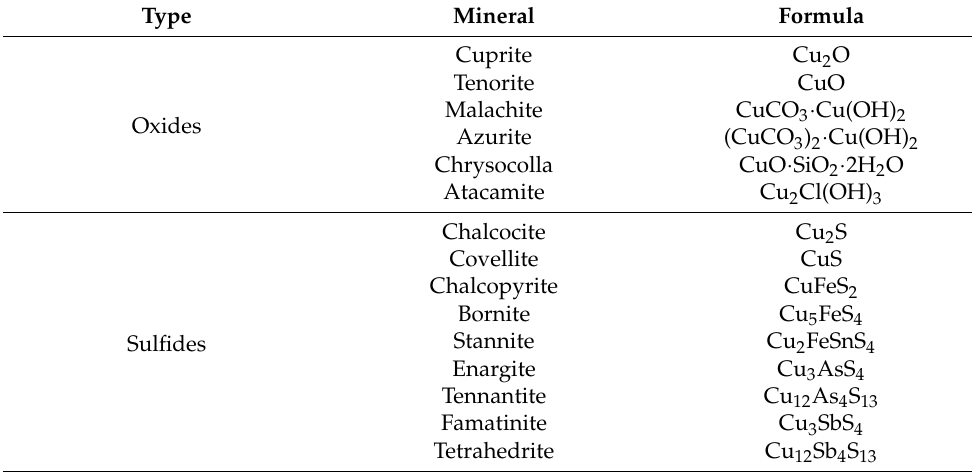
Table 1. Main copper minerals found in nature.